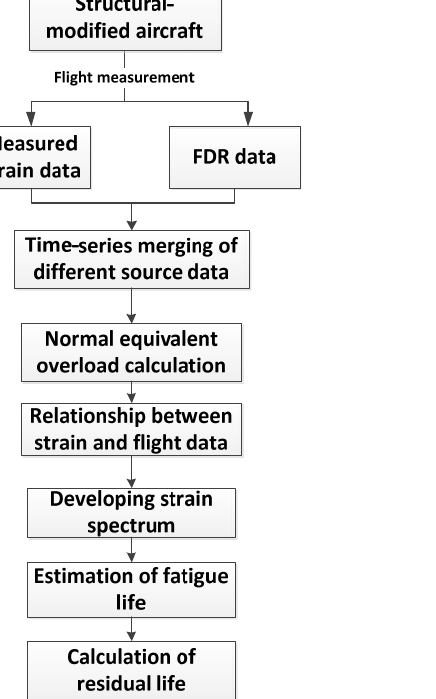
Figure 8. Flowchart of strain spectrum development from flight tests and fatigue life estimation for aging aircraft [31].